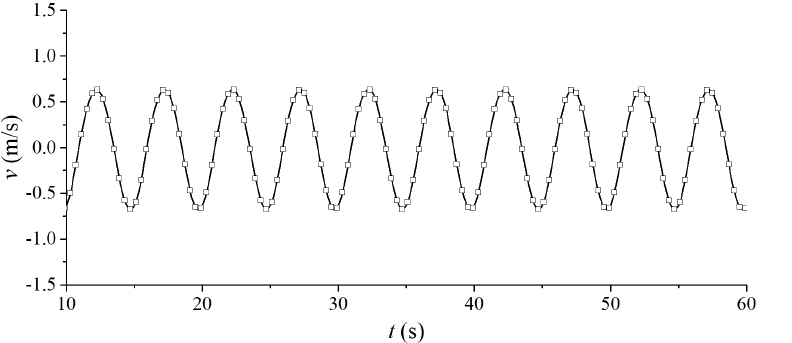
Figure 13. Velocity time histories of the floater when linear damping coefficient C is 20,000 N/(m/s).